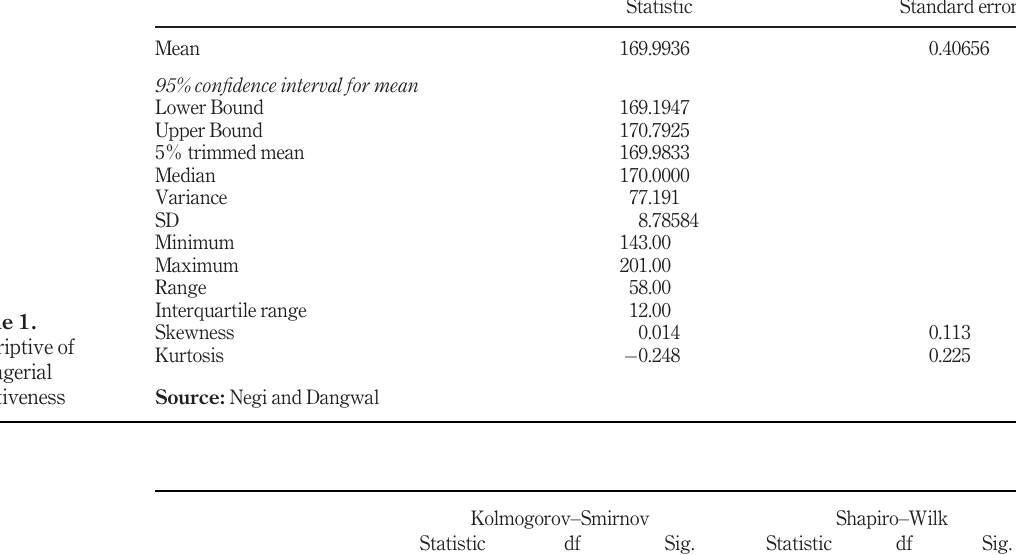
Table 2. Tests of normality